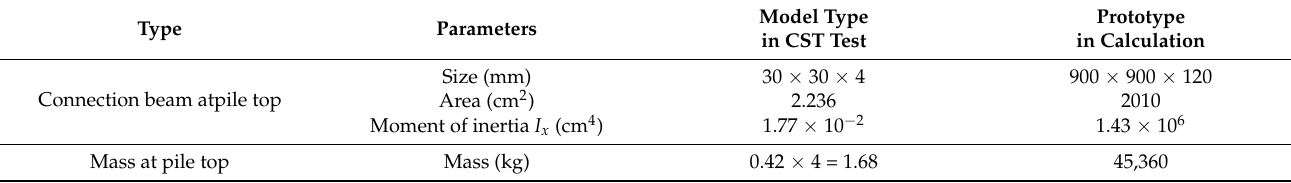
Table 4. Physical parameters of connection beam at pile top and